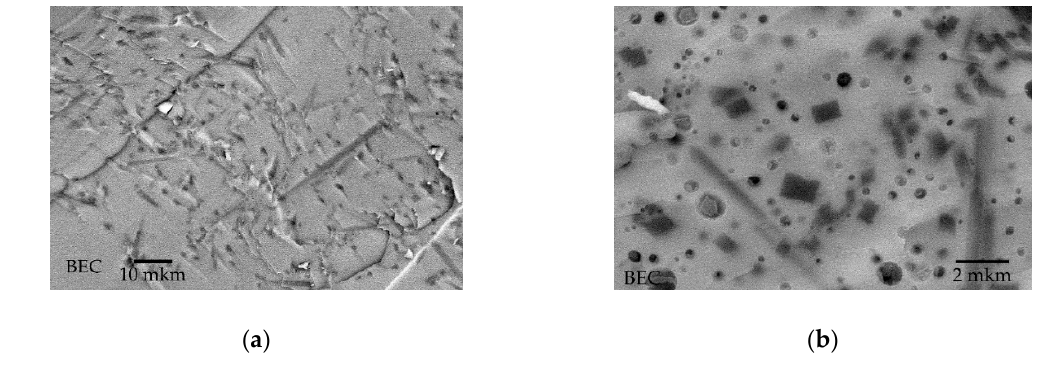
Figure 14. Backscattering SEM images of ( a ) transparent and ( b ) opaque GdAB-based glass–ceramics Figure 14b reprinted from the Journal of Crystal Growth, 457, Naprasnikov D.A., Maltsev V.V., Leonyuk N.I., Gorbachenya K.N., Kurilchik S.V., Kisel V.E., Kuleshov N.V. Micro-crystallization and